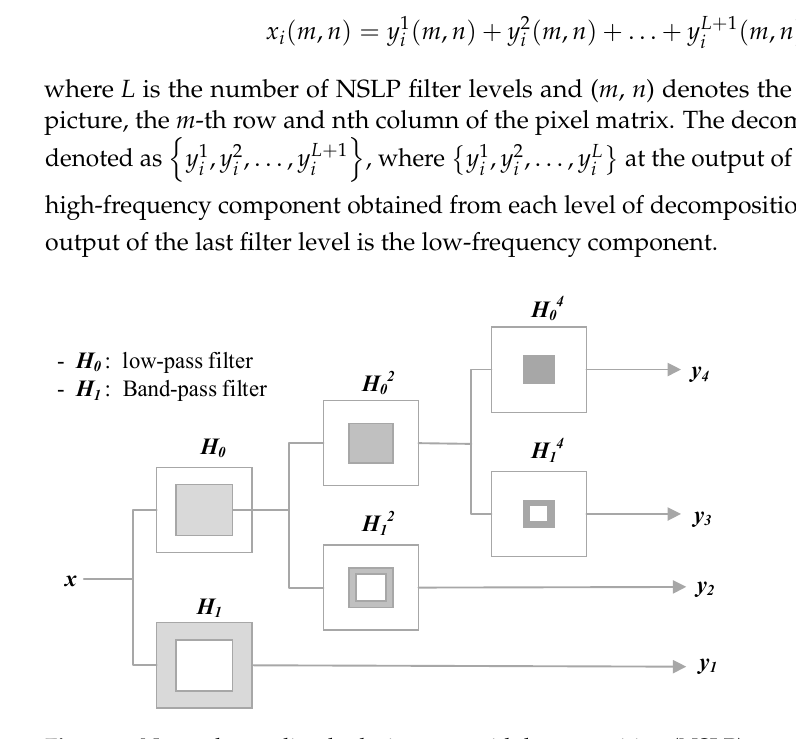
Figure 3. Non-subsampling laplacian pyramid decomposition (NSLP) structure with a three-stage filter cascade.